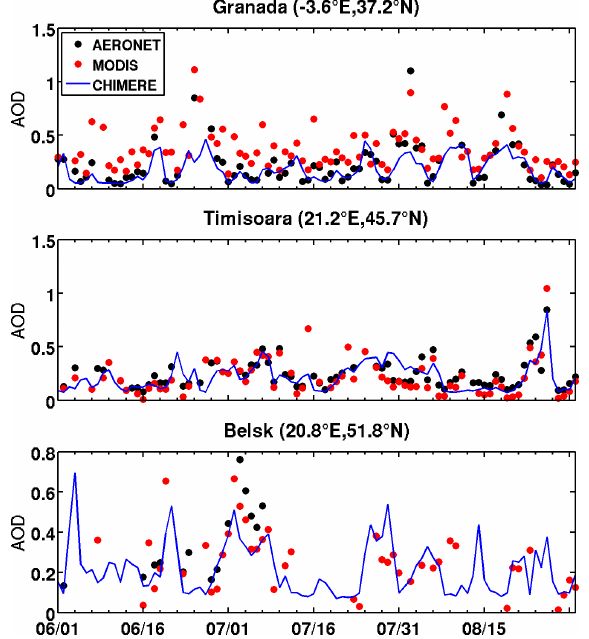
Figure 4. Time series from 1 June to 31 August of the daily AOD at 500nm from three AERONET stations. Top station is Granada in Spain, middle is Timisoara in Romania, and bottom is Belsk in Poland. Values from MODIS at 550nm are also indicated in red dots at these stations, as well as the simulated spatially co-localized 550nm AOD from CHIMERE (blue